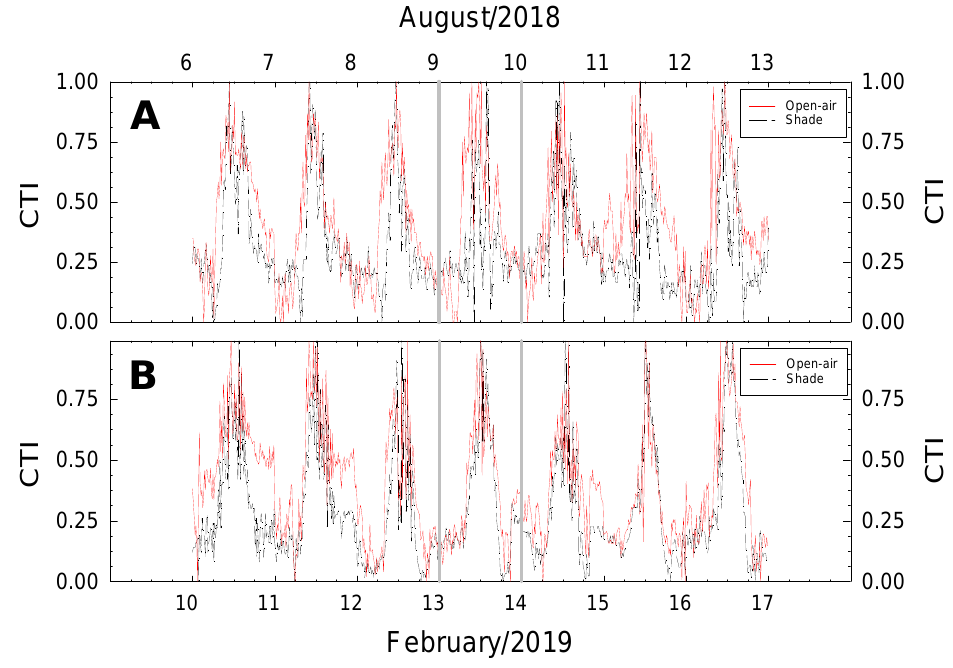
Figure 7. Canopy thermal index (CTI) for representative weeks of summer (6–13 August 2018; A ) and winter (10–17 February 2019; B ) in lime trees grown in open-air (solid line) and shaded (dashed line) conditions. Vertical grey lines indicated the measurement days (9 August 2018 and 13 February 2019). Lines are the 15-min average values of two replications.